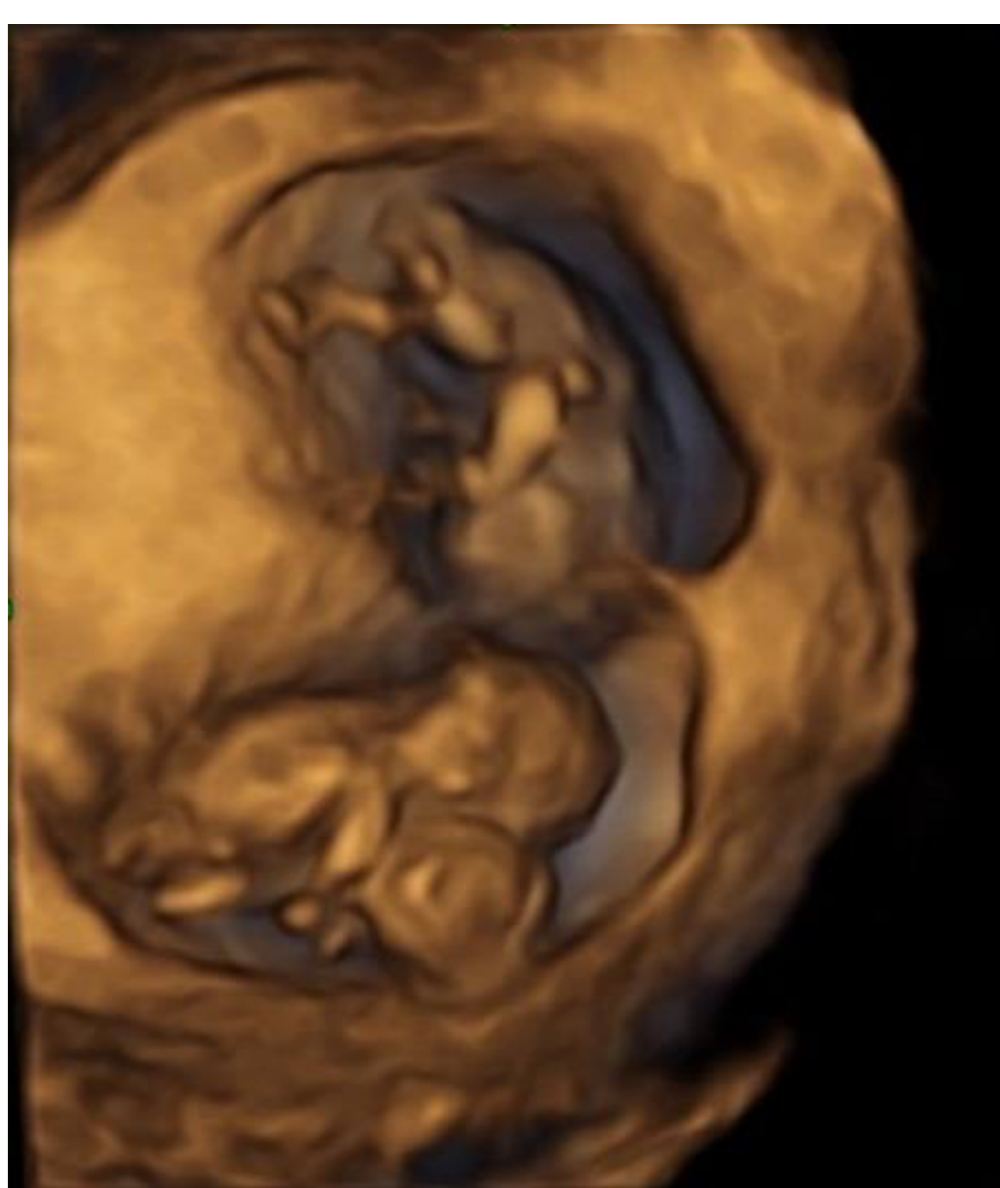
Figure 1. CT in a triplet pregnancy revealed during a 4d ultrasound examination.